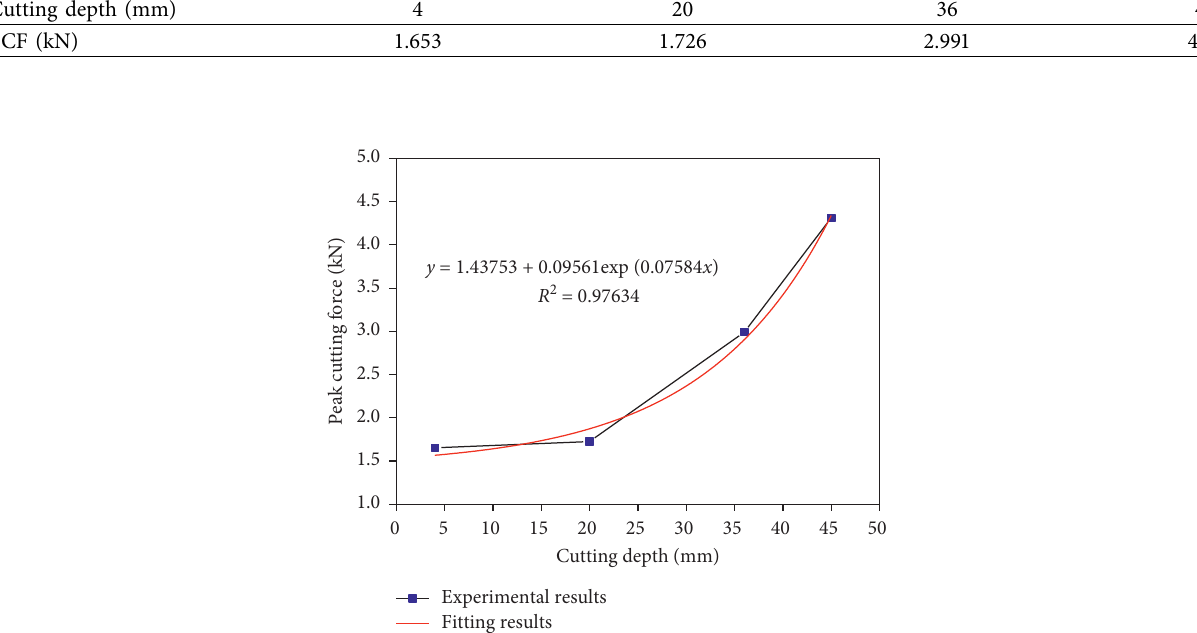
Figure 25: The relationship between PCF and cutting depth of conical